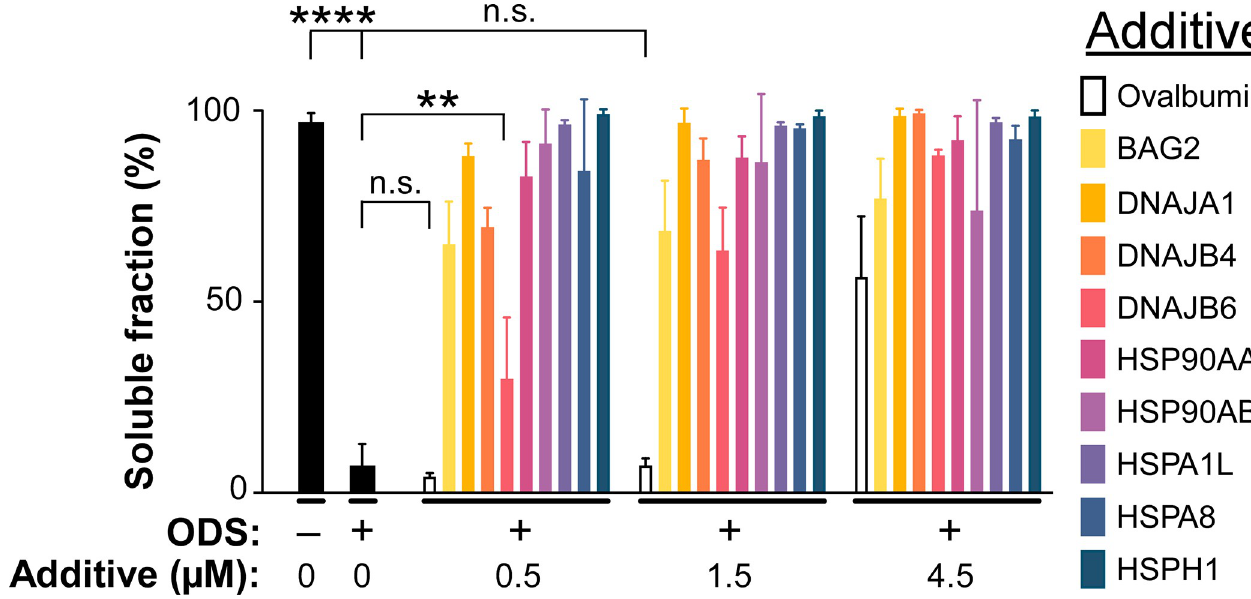
Fig 8. Molecular chaperones associated with tauopathy resistance antagonize 2N4R tau aggregation at sub-stoichiometric concentrations. Full length 2N4R tau (1.5 μ M) was incubated (16 h at 37˚C) with or without ODS inducer (50 μ M) in assembly buffer and various concentrations of each chaperone or ovalbumin control protein (0, 0.5, 1.5, 4.5 μ M). Aggregation products were centrifuged and the amount of tau protein present in supernatant and pellet fractions determined by SDS-PAGE. Each bar represents the proportion of tau in the supernatant fraction (triplicate determination ± S.D.). n.s. = not significant, ** p < 0.01, **** p < 0.0001 for comparison with soluble tau levels in ODS control samples. All comparisons to ODS control were significant at to the level of p < 0.0001, unless marked otherwise. Although tau remained completely soluble under these conditions in the absence of ODS inducer, the presence of ODS shifted tau out of the soluble fraction into insoluble forms. The additional presence of chaperone proteins depressed aggregation, leading to concentration dependent increases in soluble tau relative to the ODS only control.